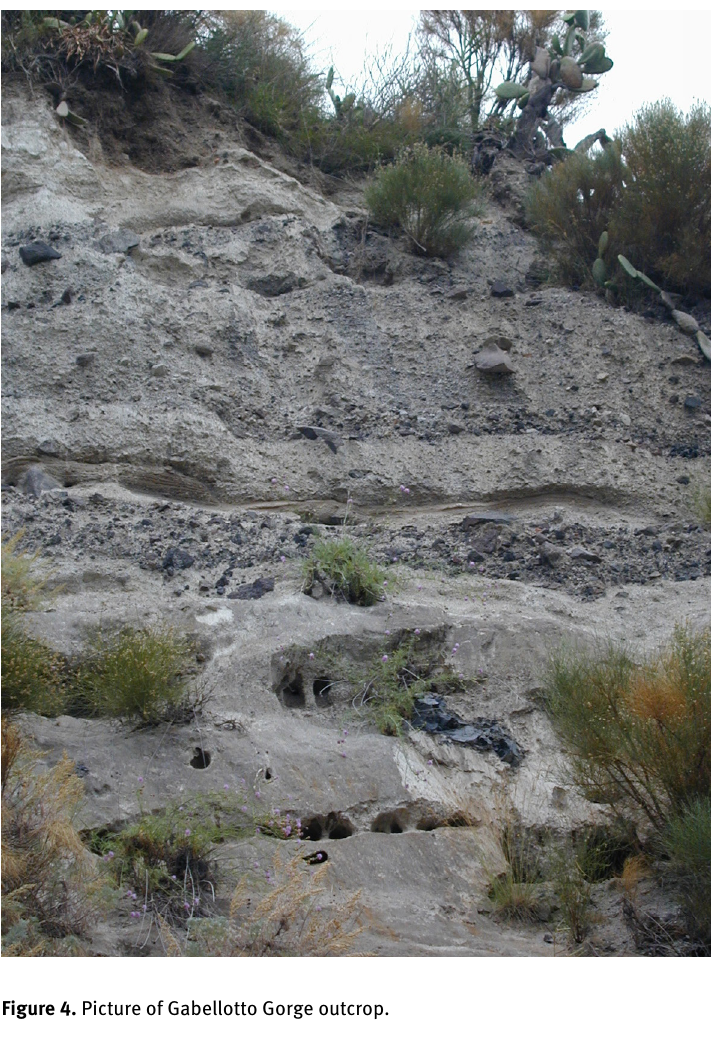
Figure 4. Picture of Gabellotto Gorge outcrop.